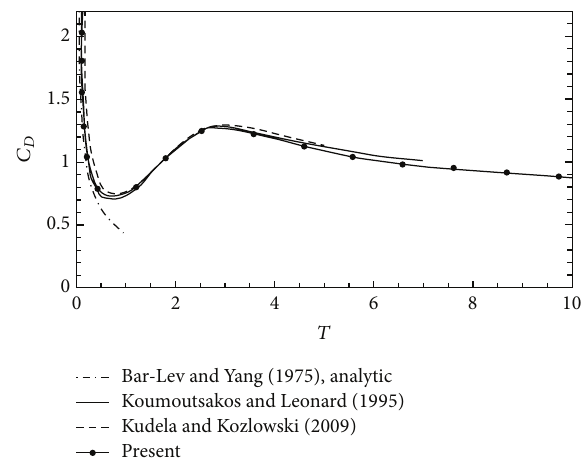
Figure 4: Time evolution of the drag coefficient for the impulsively started cylinder at Re = 550 compared with the short-time theoretical result of Bar-Lev and Yang [18], the vortex method result of Koumoutsakos and Leonard [19], and the Vortex-In-Cell method result of Kudela and Kozlowski